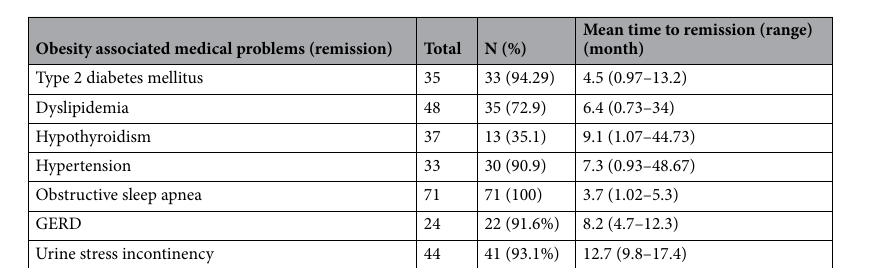
Table 3. Obesity associated medical problems remission in super-obese patients undergoing one anastomosis gastric bypass.